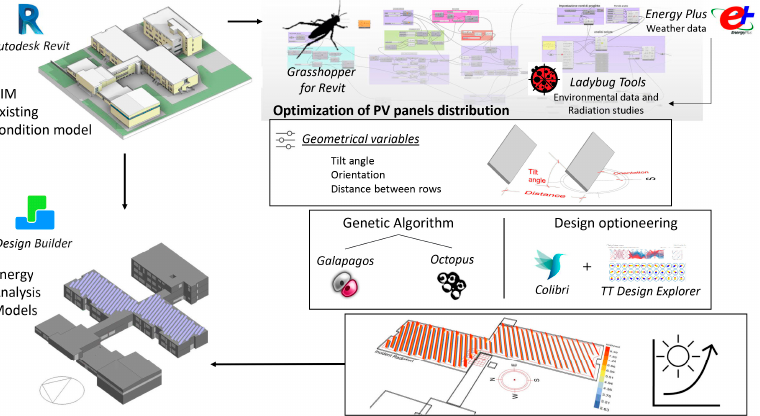
Figure 2. Optimization of PV panels workflow: starting from the BIM model of the building, realized with Revit, an optimization procedure is set in Grasshopper thanks to an interoperable plugin. The model is analyzed to select the roof of interest and surfaces casting shadows. In Grasshopper, the geometry of a single panel and the one of the arrays are generated and the radiation analysis is set through the Ladybug plugin with reference to Energy Plus weather data. Once the geometrical variables are selected, a single objective optimization is performed with Galapagos, while Octopus is used for multifactorial analysis. Results are validated with a design optioneering procedure implementing Colibri plugin and TT DesignExplorer. A Design Builder analysis was finally run coupling the building geometry extracted from the BIM model and modeling PV modules according to the optimized distribution.